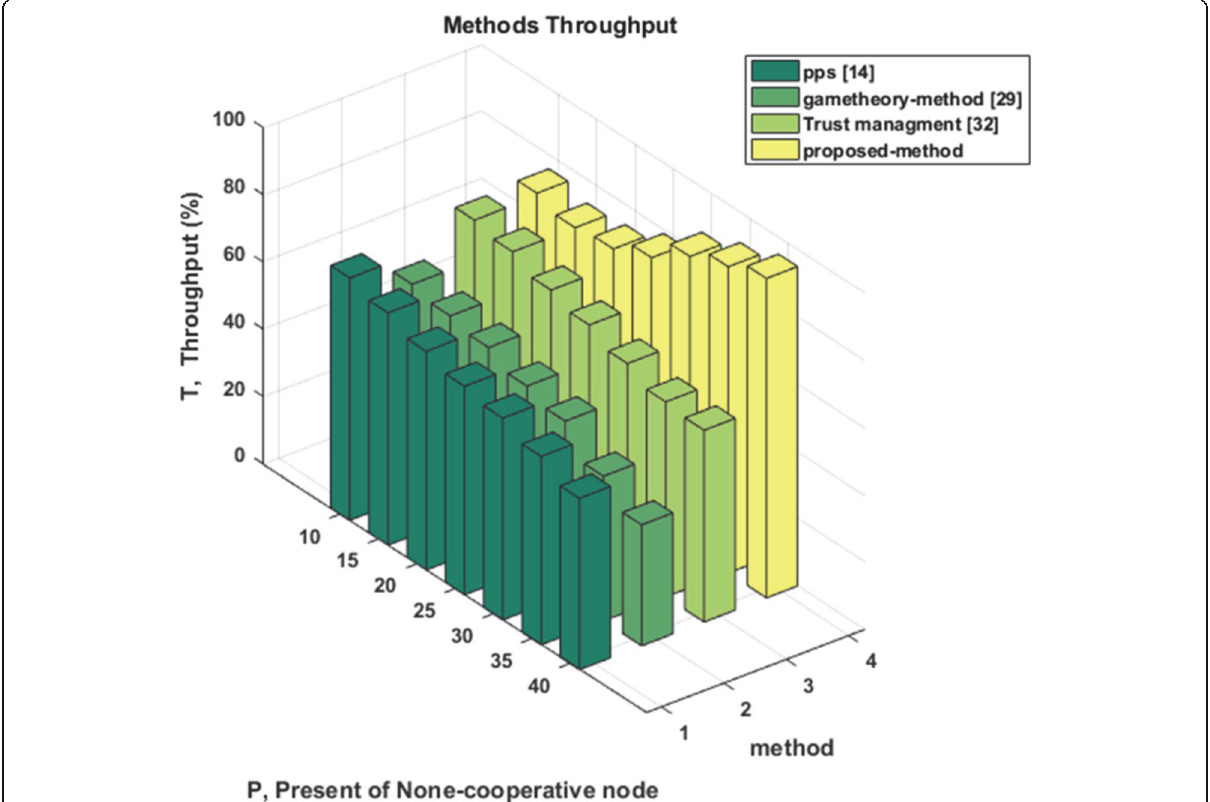
Fig. 12 Comparison of the throughput metrics in a different